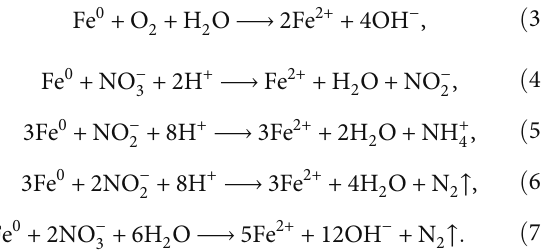
Figure 11: Change in nitrogen species over